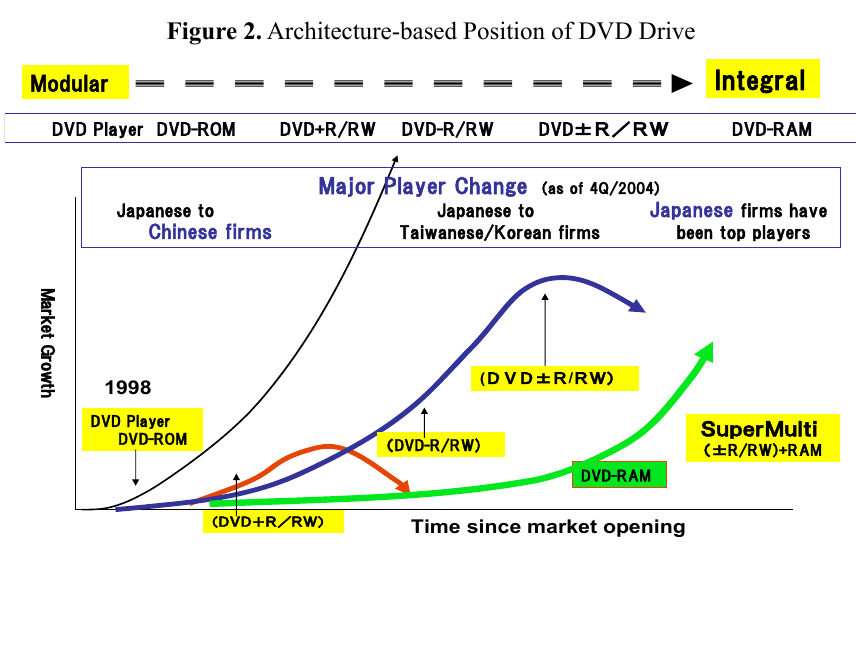
Figure 2. Architecture-based Position of DVD